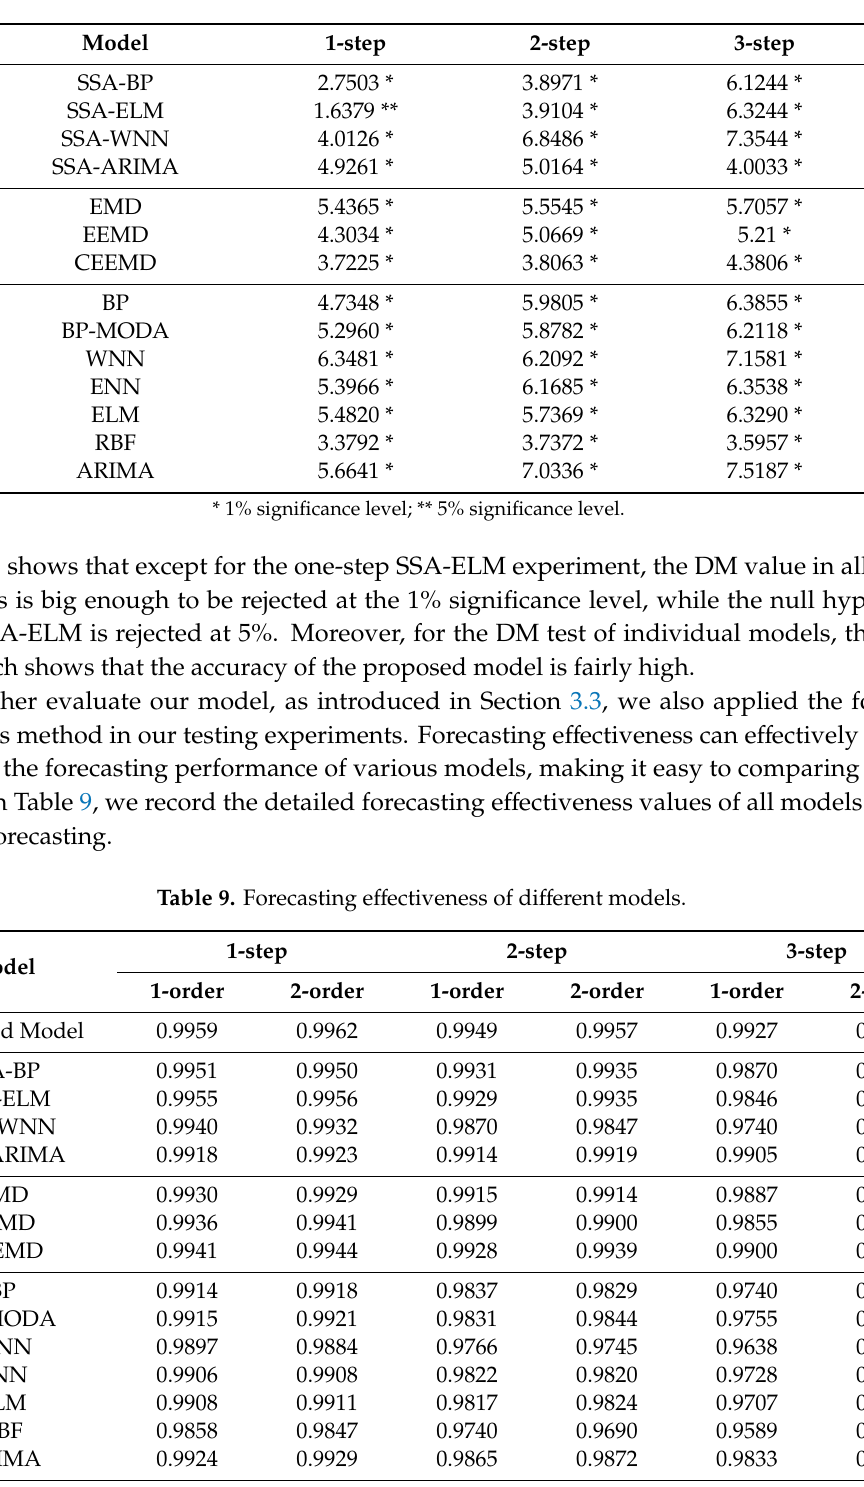
Table 8. DM test of di ff erent models.